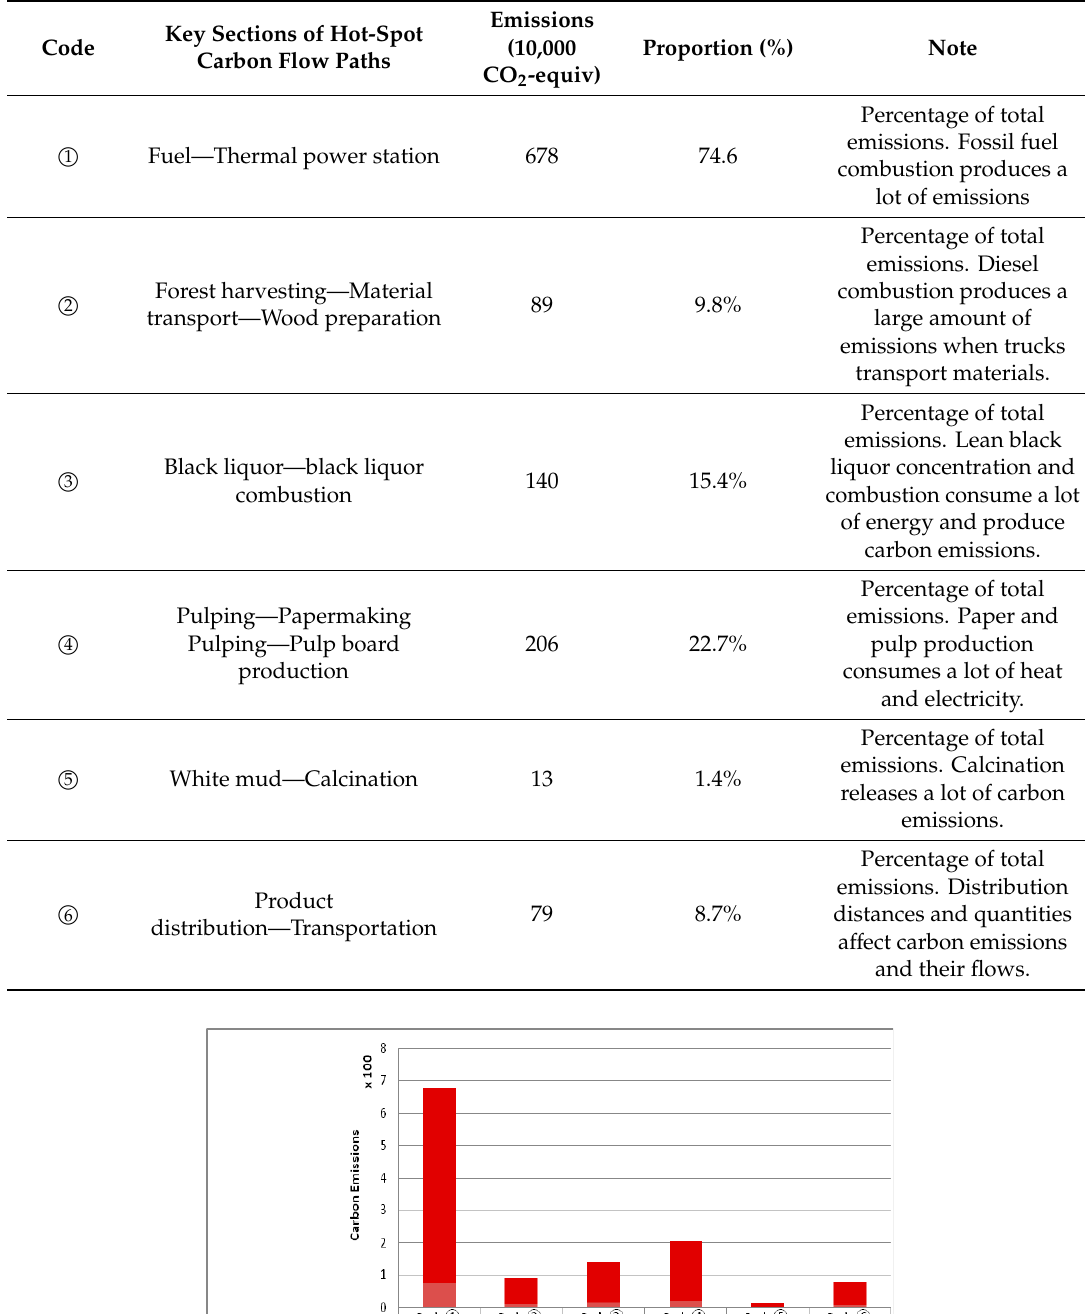
Table 2. Hot-spot paths of carbon flows unit: Ton.